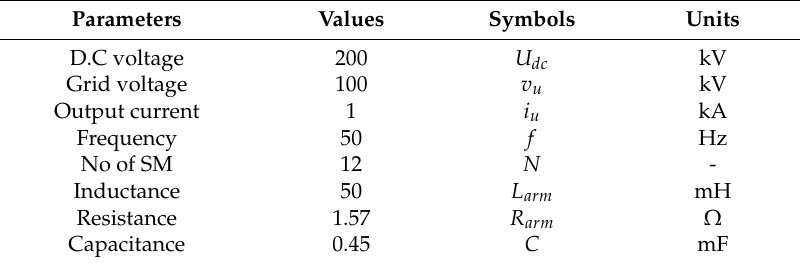
Table A1. Converter parameters.